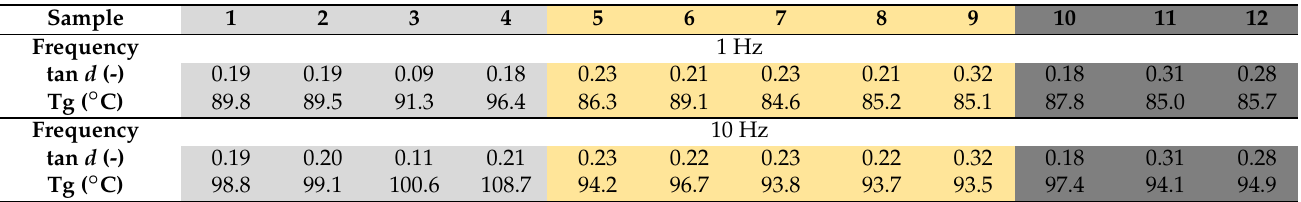
Figure 9. Effects of frequencies (Sample 8, AFRP): 1 Hz (continuous line); 10 Hz (dashed line). Table 4. Loss factor at Tg